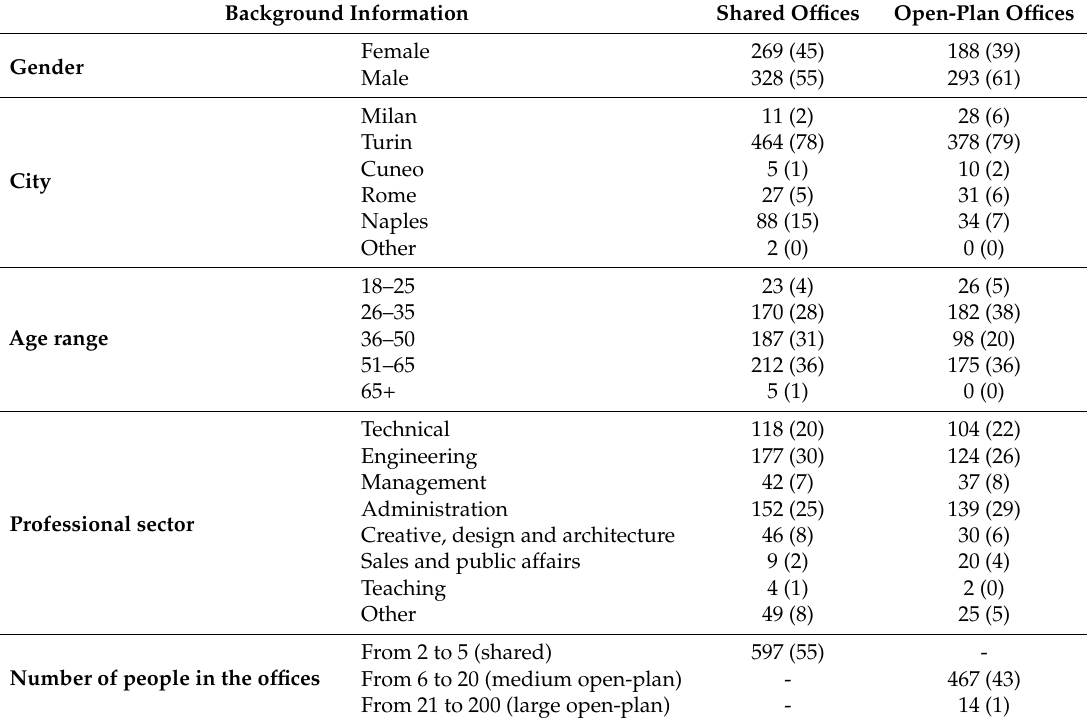
Table 1. Main characteristics of the total sample (N = 1078) subdivided into shared and open-plan offices. The percentages of the two samples are indicated in square